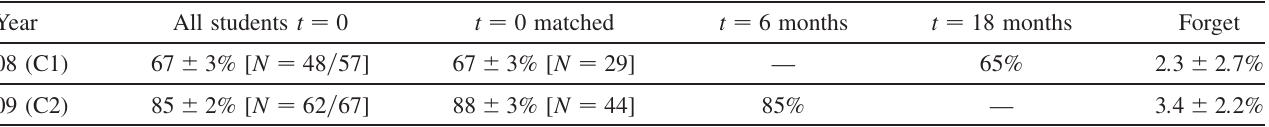
TABLE I. QMCS results for the two classes showing (1) averages for all students who completed the QMCS at the end of their respective course, along with number of students N taking the exam compared to total number enrolled; (2) end-of-course average for that subset for whom we have matched data for both the end of the course and after the corresponding retention interval; (3) and (4) average at the end of the respective 6- and 18-month retention intervals; and (5) ‘‘Forget’’ is the average of the differences for each student between t ¼ 0 score and t ¼ 6 - or 18-month retention score with the standard error in the difference. a N is 29 for the top-right four columns and 44 for the bottom-right four